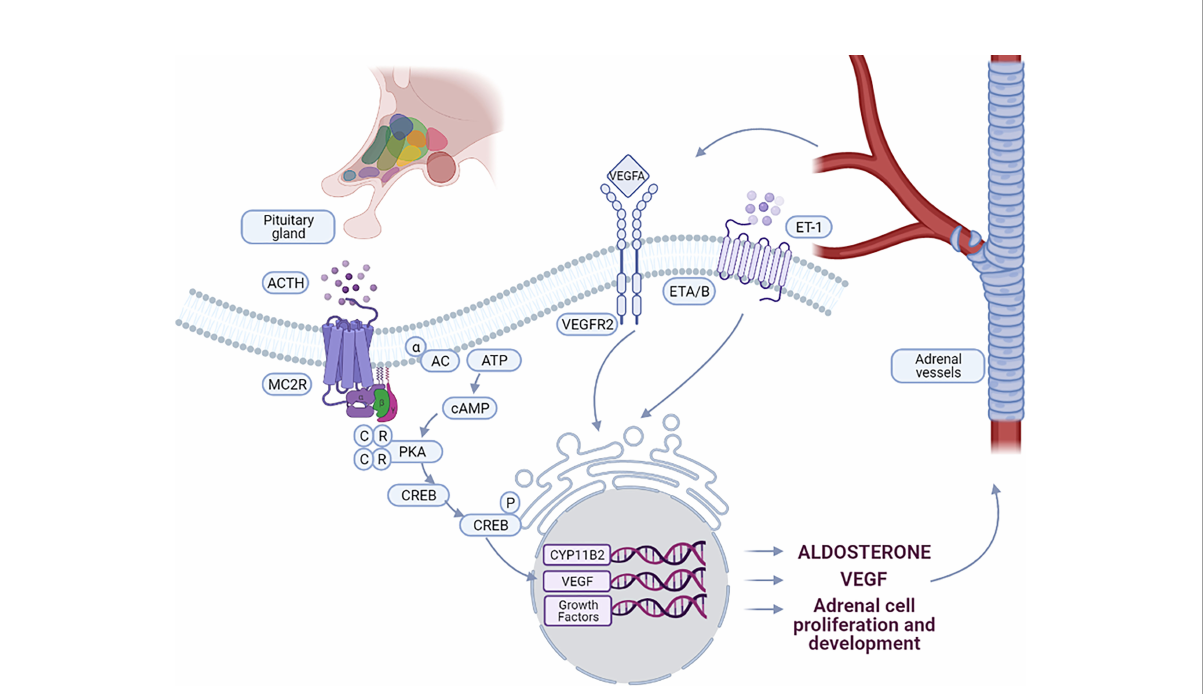
FIGURE 1 Interaction between vascular and steroidogenic cells in adrenal. ACTH, produced by the pituitary gland, controls the interactions between steroidogenic cells and vessels. Binding of ACTH to MC2R leads to the activation of PKA signaling pathway, stimulating CYP11B2 expression and aldosterone biosynthesis. ACTH stimulates also the expression of VEGF-A and speci fi c growth factors by adrenal cells leading to vessel growth. By binding to VEGFR2, VEGF-A stimulates on one hand endothelial cell growth and on the other hand expression of growth factors involved in the maintenance and function of the adrenal cortex. Aldosterone biosynthesis is also induced by ET-1 through binding to the endothelin receptor ETA and ETB, expressed in the ZG of the adrenal